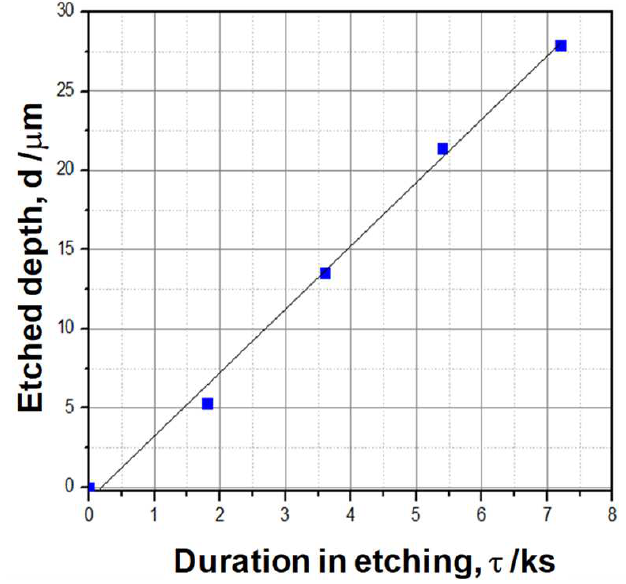
Figure 7. Relationship of the etched depth into VGS with increasing the oxygen plasma etching duration. Raman spectroscopy was utilized to investigate the difference in the VGS surface structures before and after the etching process. Figure 8 compared the Raman spectra of VGS surfaces before and after the oxygen plasma etching, using the excitation laser with a wave length of 532 nm. The Raman shift range was specified from 1530 cm − 1 to 1640 cm − 1 . The typical graphitic peak was detected at 1579 cm − 1 before etching and at 1578 cm − 1 after etching, respectively. No difference is detected in the G-band; the typical sp2-vibration mode is common to these two measurements. To be noticed the G (cid:48) band or the disordered G-band is also detected as a shoulder at 1620 cm − 1 after etching. This is just corresponding to a structural disorder in the sp2 structure, as reported in [22]. This structural disorder might be induced by the plasma oxidation process in the vicinity of etched edges between masked and unmasked VGS surfaces.